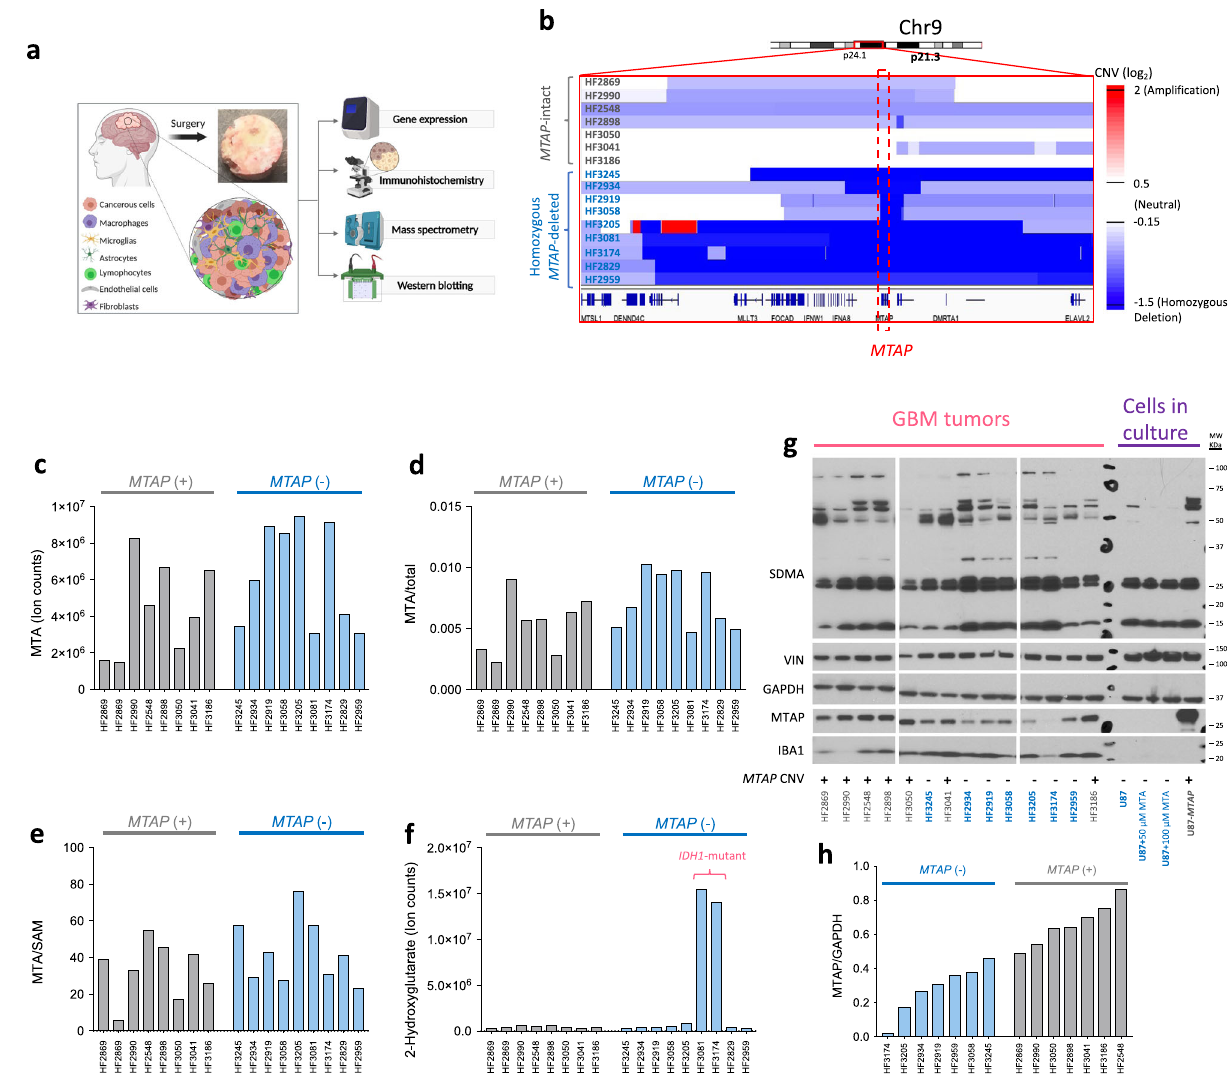
Fig. 2 No signi fi cant elevation of MTA and no speci fi c inhibition of PRMT5 activity in homozygous MTAP -deleted primary resected GBM tumors. a GBM tumors (heterogeneous mix of transformed glioma cells and non-malignant stroma) of de fi ned MTAP -deletion status (genomic pro fi ling from Kim et al. 31 ) were evaluated by mass spectrometry for MTA levels and western blot for SMDA. b Genomic copy-number data (dark blue: homozygous deletion, dark red: ampli fi cation) around the 9p21 locus. Each strip in the y -axis represents a single tumor at the speci fi c chromosomal location ( x -axis). c MTA levels in homozygous MTAP -deleted ( MTAP − ) versus MTAP -intact ( MTAP + ) GBM tumors, using the BIDMC mass spectrometric platform. Each bar represents MTA levels for each tumor ( N = 1). There is a 1.4-fold increase in the median MTA levels (absolute ion counts) in MTAP -deleted tumors compared to intact tumors ( p = 0.20, unpaired 2-tailed t test with unequal variance). d , e Same data but expressed normalized to total ion count for sample loading normalization ( d ) and as a ratio to SAM levels to account for methionine salvage pathway activity ( e ). Regardless of normalization, no signi fi cant elevation of MTA in MTAP -deleted tumors was evident. In contrast, f tumors with IDH1 mutation stand out by their dramatic elevation of 2-hydroxyglutarate (2-HG), providing a positive control for genomic/metabolic correlation. g To evaluate PRMT5 activity, GBM tumor lysates were immunoblotted for SDMA, repeated once. As a positive control, we assessed SDMA levels in MTAP -deleted U87 glioma cells in culture, alone or treated with exogenous MTA versus MTAP -reconstituted (U87- MTAP ) cells. SDMA levels were lower in U87 than in U87- MTAP cells, indicating partial inhibition of PRMT5. SDMA levels further decreased following MTA treatment. Unlike in cultured cells, no speci fi c decrease in SDMA levels was observed in MTAP -deleted versus intact GBM tumors. The presence of myeloid cells in a tumor is con fi rmed by the myeloid marker IBA1 in tumor lysates but not seen in cells in culture. h MTAP protein levels corrected for loading with GAPDH control (samples derive from the same experiment and gels were processed in parallel). Due to the presence of non-malignant MTAP-expressing cells in the lysate of whole tumors, MTAP protein levels are not zero for homozygous MTAP -deleted tumors; however, on average, they have lower MTAP protein levels compared to intact correlation between SDMA levels and tumors ’ MTAP status, we antibody (Fig. 2g). Unlike cell culture experiments, primary noticed some variation in SDMA levels between tumors tumors showed no meaningful decrease in levels of SDMA, regardless of their MTAP status. Unlike cells in culture, representing PRMT5 activity, in homozygous MTAP -deleted homozygous MTAP- deleted GBM tumors express non-zero compared to MTAP -intact human GBM tumors. These data are MTAP levels in western blot (Fig. 2g). This is because human consistent with the marginal elevation of MTA, intracellular or GBM tumors are comprised of a mix of malignant glioma extracellular, in MTAP -deleted tumors. While we did not fi nd a